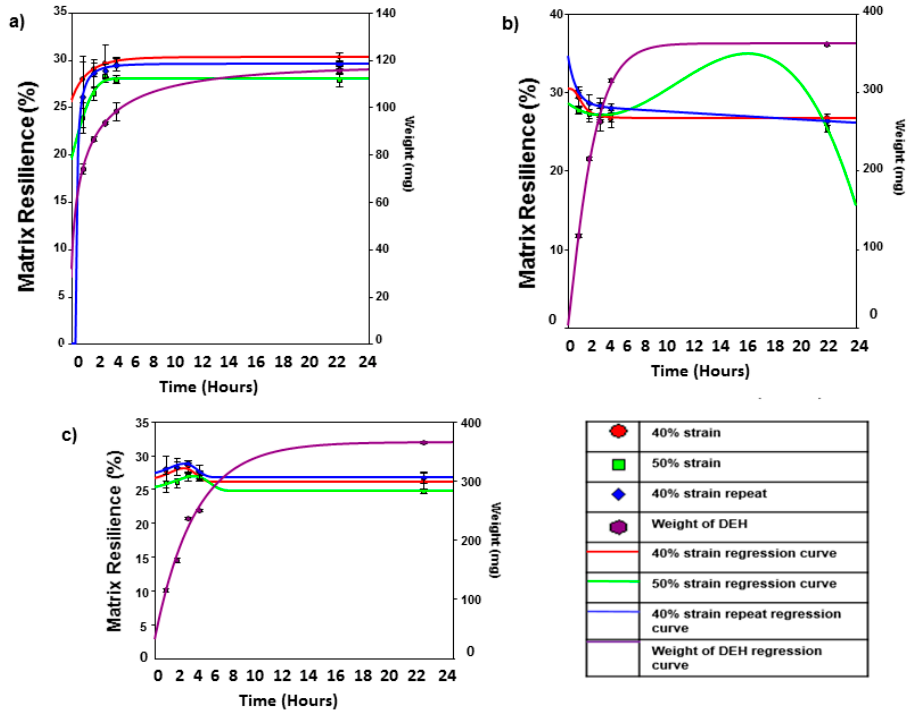
Figure 4. Scatter plots of the hydrogel in simulated gastric buffer ( Graph a ); simulated intestinal buffer ( Graph b ) and deionized water ( Graph c ).